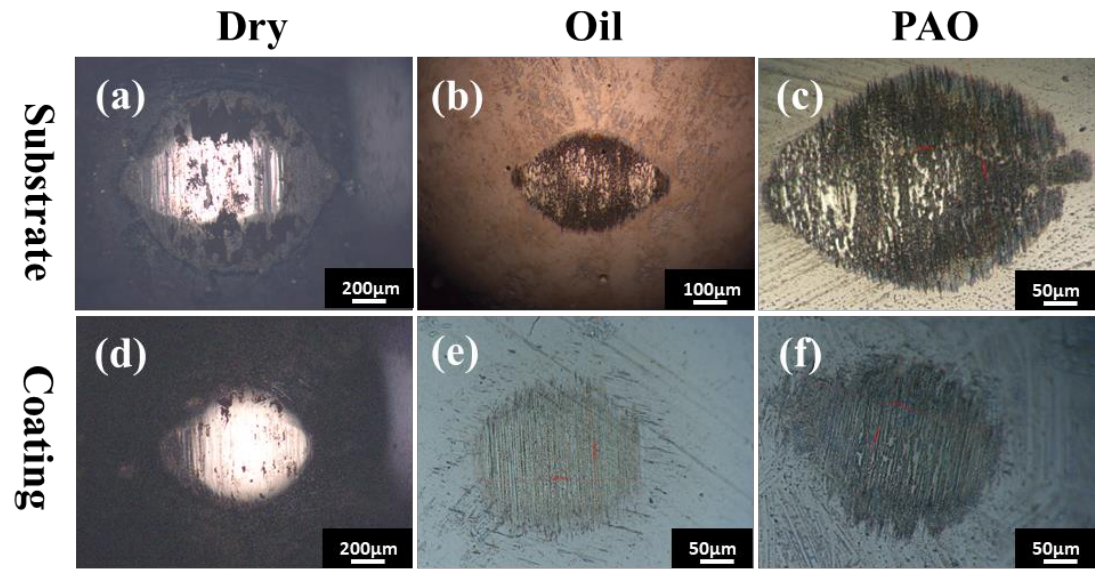
Figure 10. Optical observation of wear scars from GCr15 balls on Al – Si substrates ( a – c ) and Ni – Co – P/Si 3 N 4 composite coated specimens ( d – f ) under dry conditions and with lubrication with PAO and engine oil.